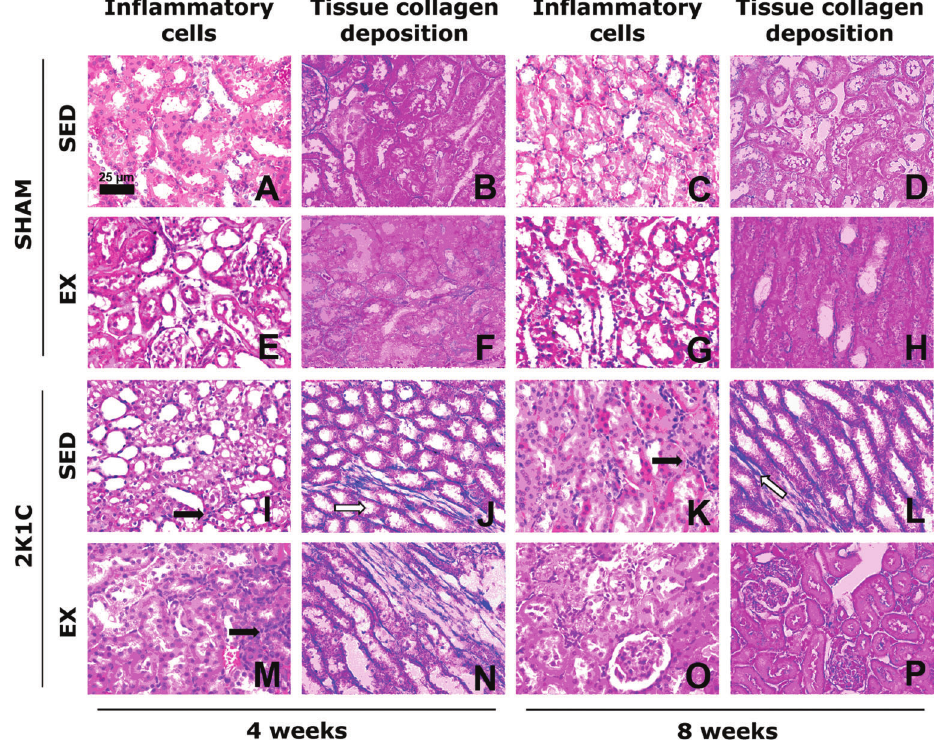
Figure 7. Photomicrographs of the right kidney of normotensive (SHAM) rats and hypertensive (2K1C) rats, either sedentary (SED) or subjected to physical exercise training (Ex, swimming) for 4 and 8 weeks. The number of in fl ammatory cells is consistent with the framework of normality in SHAM SED rats ( A and C , respectively). The number of in fl ammatory cells decreased in SHAM Ex rats at week 4 ( E ) and in 2K1C Ex rats at week 4 ( M ). The in fl ammatory process (black arrows) observed in the right kidney in SHAM Ex rats at week 8 ( G ), 2K1C SED rats ( I and K ), and 2K1C Ex rats ( M and O ) was similar to the normal pattern observed in SHAM SED rats. Note the area of collagen deposition compatible with normality in SHAM SED rats ( B and D ). Note the large area of collagen deposition (white arrows) in 2K1C rats ( J and L ) and small area of collagen deposition in 2K1C Ex rats ( N and P ). A , E , I , M , C , G , K , and O are stained with hematoxylin and eosin. B , F , J , N , D , H , L , and P are stained with Masson trichrome. All photomicrographs are magni fi ed to 440 (cid:1) (bar=25 m